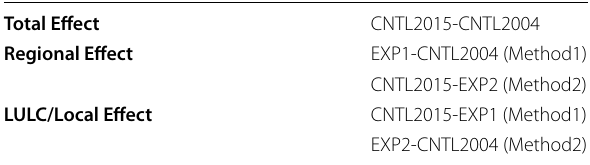
Table 1 Details of the methodology used for segregating into regional and LULC